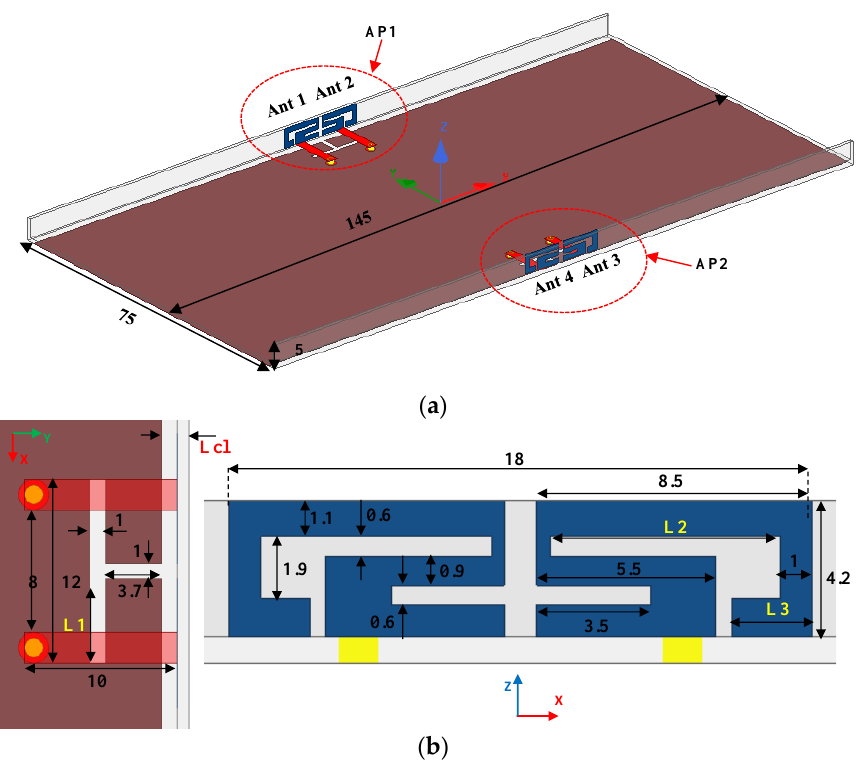
Figure 1. ( a ) The overall structure and ( b ) concrete construction of the designed AP system.